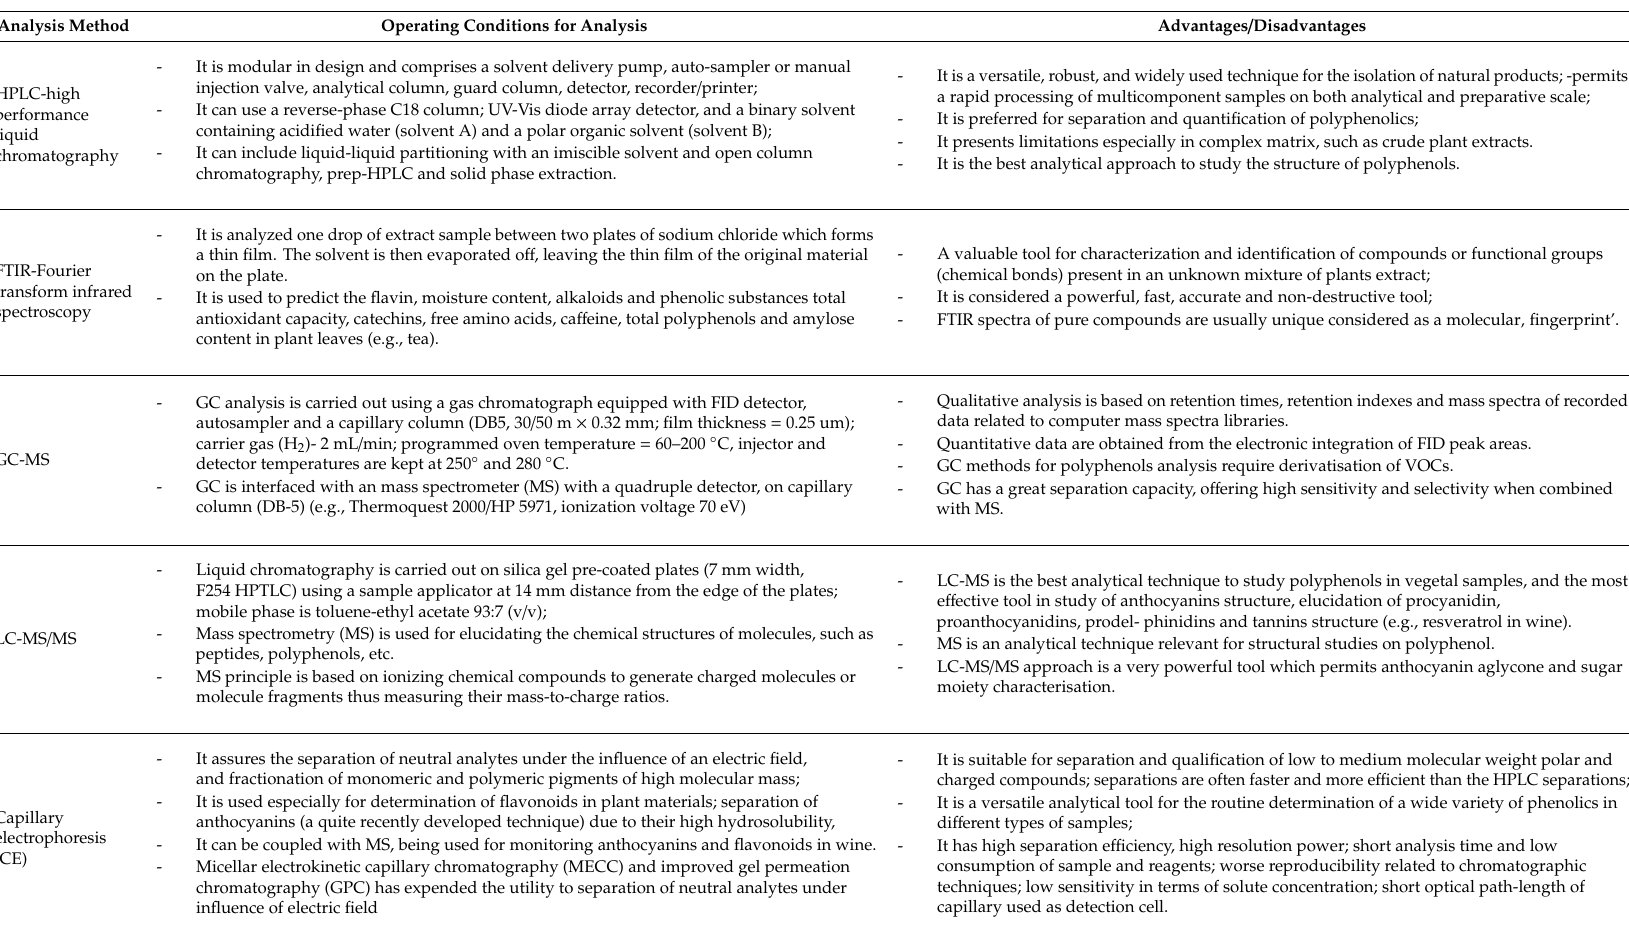
Table 4. Methods for analyzing plant extracts (adapted from